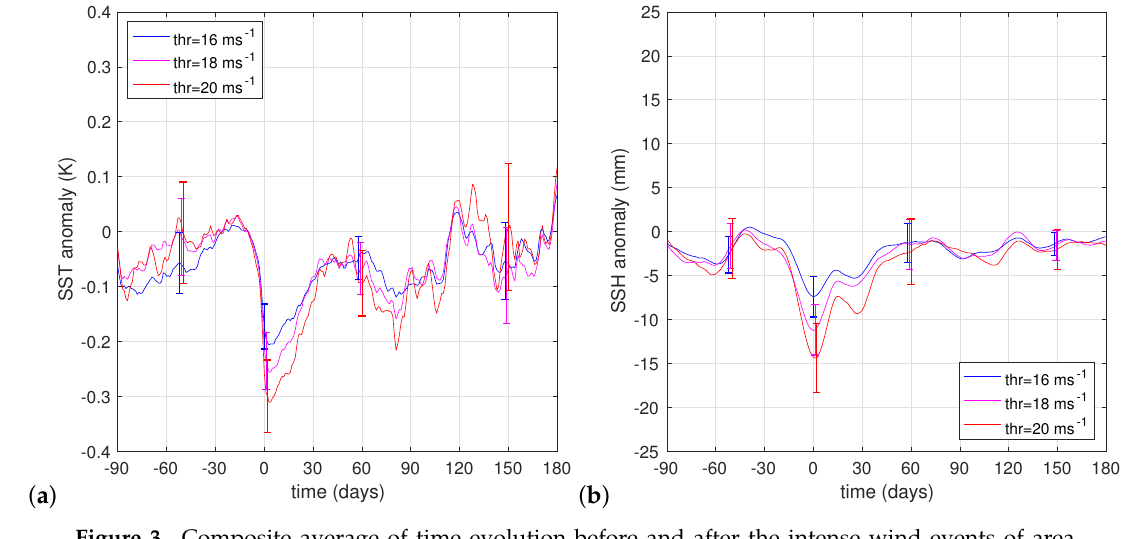
Figure 3. Composite average of time evolution before and after the intense wind events of area averaged sea surface temperature anomaly (SSTA) ( a ) and sea surface height anomaly (SSHA) ( b ) during the winter season, for wind speed thresholds of 16 (blue), 18 (magenta) and 20 (red) ms − 1 . Error bars around − 50, 5, 60 and 150 days are computed as 2 standard deviations of the composite sample. Note the different axis range in the two